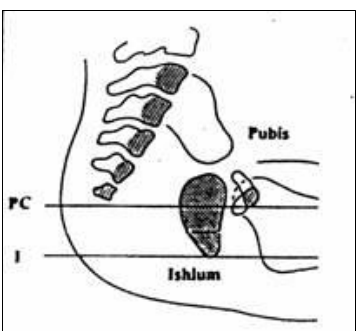
Figure 2: Interpretation of Invert gram or CTPL